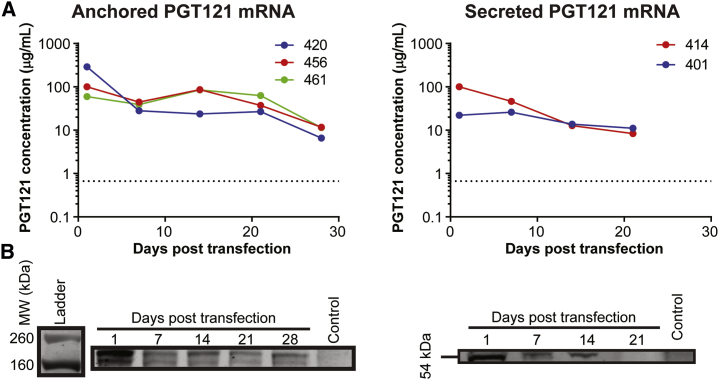
aPGT121 Persists in Vaginal Secretions out to 28 Days Post-transfectionThree sheep were transfected with two doses of 750 μg of mRNA encoding for aPGT121, while another two sheep were transfected with an equal mass of sPGT121 mRNA. Vaginal secretions were collected at 1, 7, 14, 21, and 28 days post-transfection. (A) Longitudinal sampling of PGT121 concentrations over time, for all animals. The horizontal asymptote represents the limit of detection. Individual and mean values can be found in Table S1. (B) Antibody concentrations in vaginal secretions were quantified via western blot analysis, using a standard curve of purified PGT121-NanoLuc protein. The expected size of aPGT121-NanoLuc was confirmed to be around 195 kDa. For secreted antibody, the LC uncoupled from the HC, resulting in a 54 kDa band.